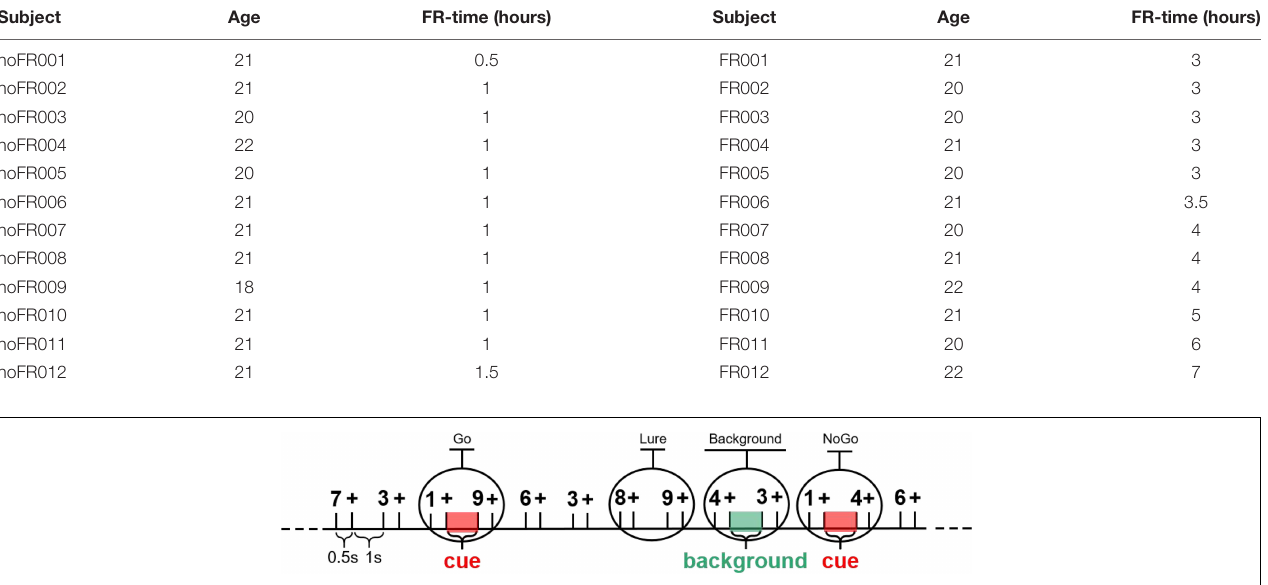
FIGURE 1 | The modified AX-type Continuous Performance Task (AX-CPT). Participants were instructed to press one key using their index finger only when the numeral “1” was directly followed by “9”. All other sequences were to be ignored. The one-second-long (0.5–1.5 s) post-stimulus epochs that “+” presented after numeral “1” stimulus (Go and NoGo, defined as cue condition) and numeral “4” stimulus (only in background condition) were selected in this study.